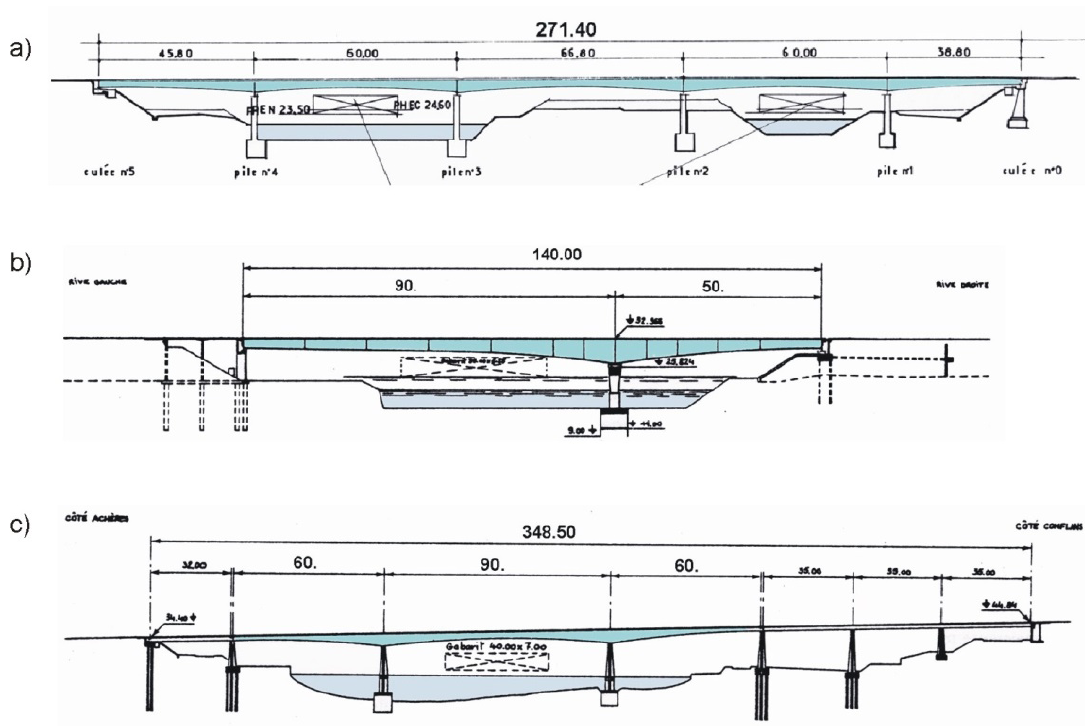
Figure 34: Bridges described in OTUA bulletin n°6 by Henri Grelu: a) l’Oise A15 (1966), b) Cergy l’Hautil RD203 (1969), and c) Conflans RN 184 (1973).